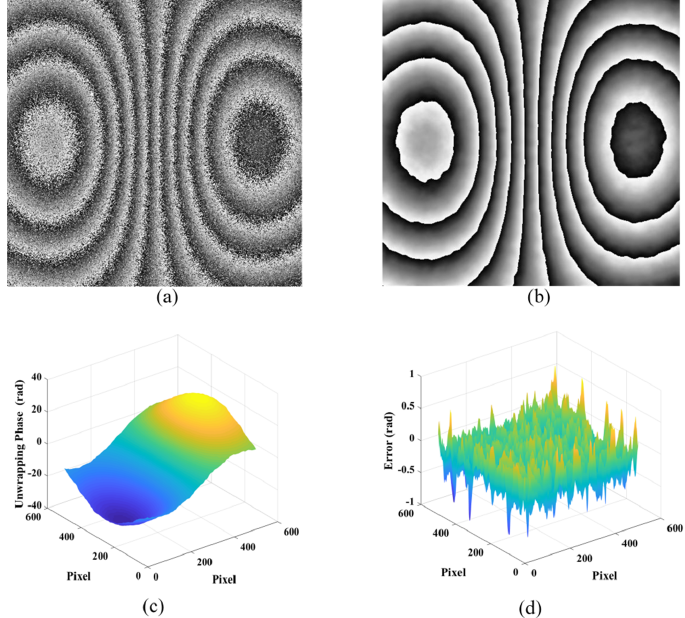
Figure 5. Simulated data (the speckle radius of 1 pixel): ( a ) Simulated noisy wrapped phase; ( b ) denoising result of ( a ) by the proposed method; ( c ) unwrapped phase of ( b ); ( d ) error distribution map of (c).